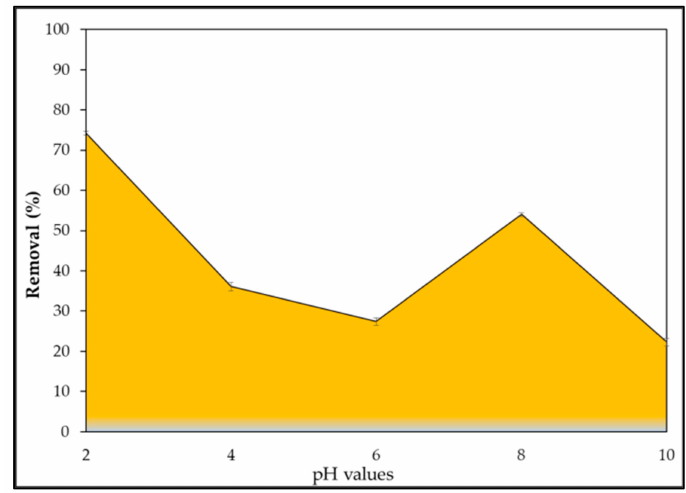
Figure 9. Effect of several pH values on IV2R